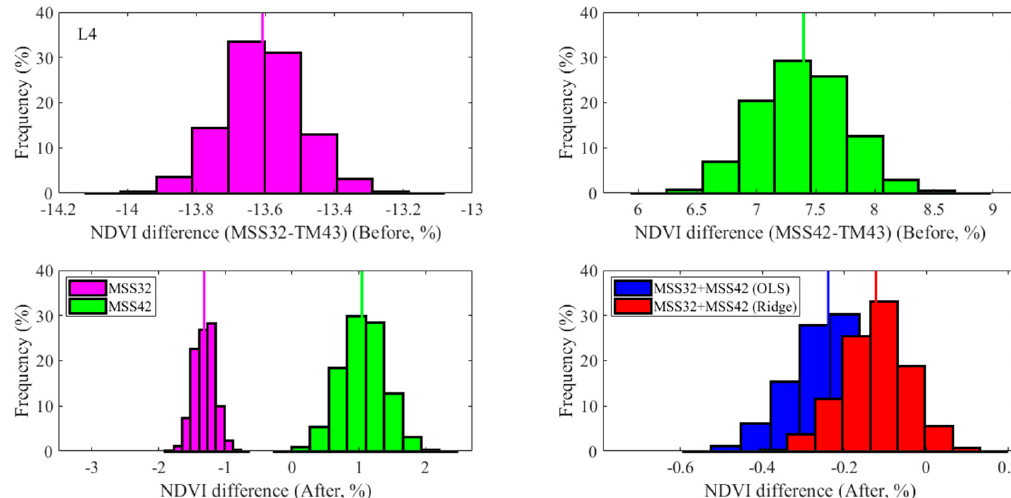
Figure 4. NDVI difference (MdRD) between the MSS and TM of Landsat 4 before (top row) and after (bottom row) transformation. Improvements associated with four transformation models are shown as “After,” which include the univariate ordinary least squares (OLS) regression models (left) and the bivariate models (through OLS and ridge regression respectively). The histograms are based on 10,000 times K-fold (K = 5) cross-validation tests, while the equally spaced steps (with 10 bins) for the histograms are 0.104%, 0.305%, 0.127%, 0.278%, 0.072%, and 0.067% respectively. The vertical lines show the median values of NDVI difference correspondingly. The median MdRD with lower and upper bounds (taken as 2.5% and 97.5% percentiles respectively) for cross-validation tests are − 13.61% (–13.84%, –13.38%) and 7.40% (6.67%, 8.11%) before transformation (top row), while − 1.32% ( − 1.62%, –1.02%), 1.05% (0.38%, 1.71%), –0.24% (–0.43%, –0.08%), and − 0.12% (–0.30%, 0.03%) after transformation through respective models (bottom row).